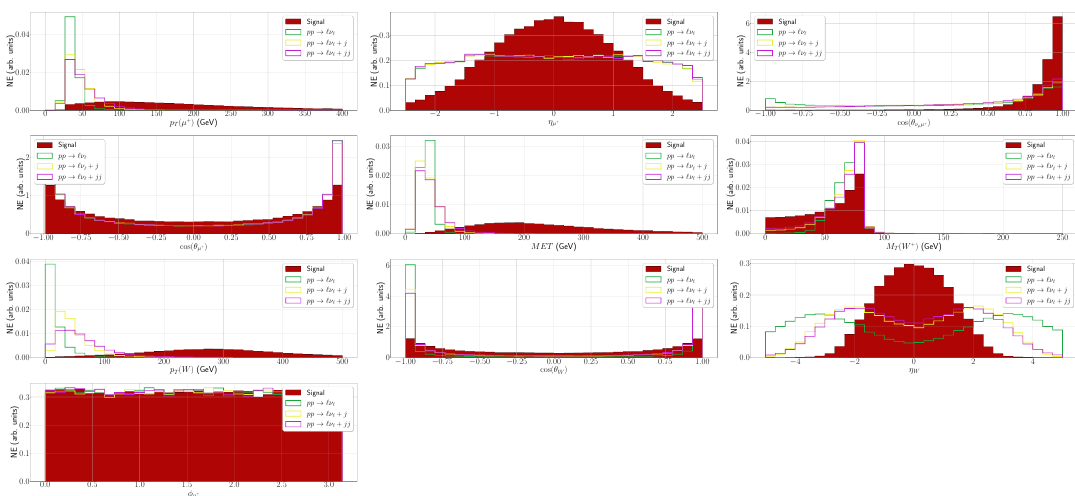
Figure 20. Dimensionless (angular) and dimension-full (kinematic) observables at lab reference frame for VLBSM channel (solid red), with pp → ‘ν (green line), pp → ‘ν + j (yellow line) and ‘ ‘ pp → ‘ν ‘ + jj (purple line) backgrounds where it is considered 30 bins for all histograms. From top left to bottom right, we have distributions for transverse momentum µ + , pseudo-rapidity µ + , (cid:17) (cid:1) , cos (cid:16) cos (cid:0) θ + , MET, transverse mass for W , transverse momentum for W , cos( θ ) , pseudo- θ W µ ν + µ µ + rapidity for W and azimuthal angle for µ + . Note that ν is the reconstructed missing energy vector, according to the discussion in section